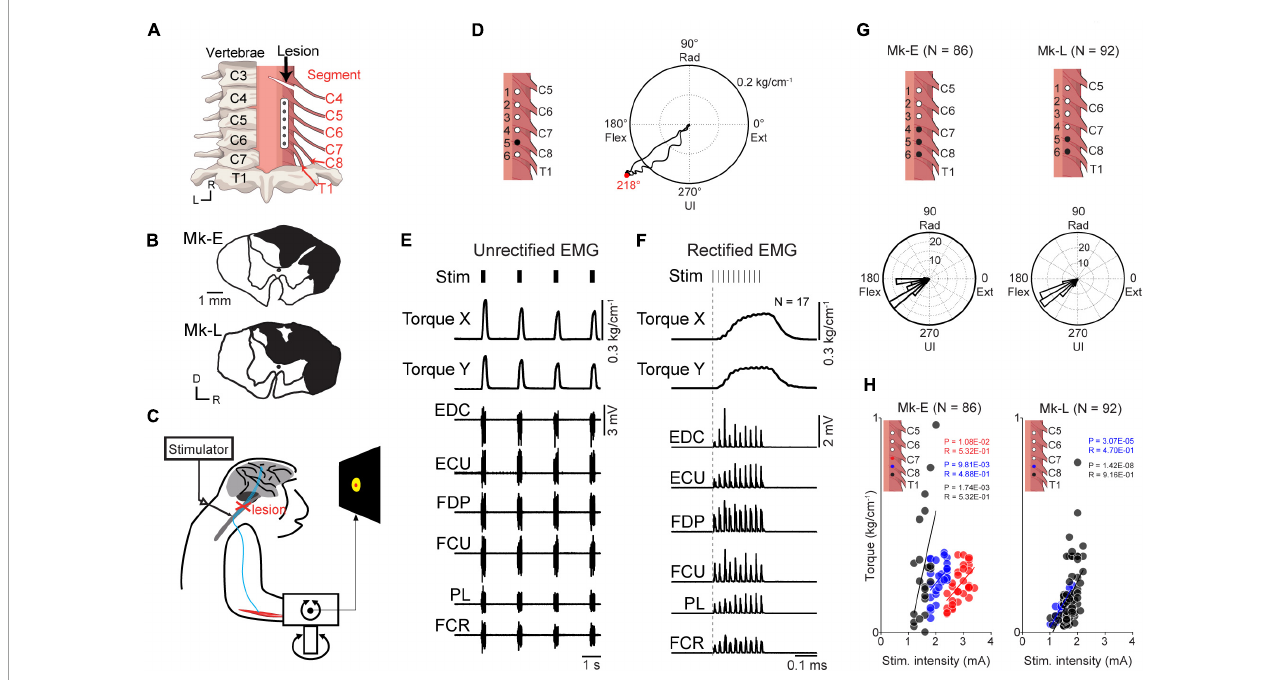
FIGURE1 Motor output evoked by subdural spinal stimulation during rest in awake monkeys with SCI. (A) A subdural 6-electrode array (platinum) was chronically implanted over the dorsal-lateral aspect of the cervical spinal cord and placed on the C6–T1 segments. A slit at the C4/C5 segment indicates the lesion site. (B) Lesion extent (black hatch) at the C4/C5 segment in individual monkeys. (C) Subdural spinal stimulation was applied at rest. (D) Typical example of average wrist torque trajectory for tonic spinal cord stimulation of C8 (black circle, electrode no. 5). Horizontal and vertical components in this trace correspond to Torque X and Torque Y in panel (F) , respectively. Red dot on the torque trajectory represents the maximum magnitude of the evoked torque. (E) Raw traces of wrist torque and EMG during subdural spinal stimulation of C8. Stimuli consisting of 10 constant-current biphasic square-wave pulses of 40 Hz with a duration of 0.2 ms and interval of 2 s were delivered through an electrode (Monkey E, post-SCI day 15). (F) Stimulus-triggered averages of wrist torque and rectified EMG. The vertical dashed gray lines represent the onset of a stimulus train. (G) Population data for the directions of the evoked torque induced by subdural spinal stimulation at rest. Top: black dots on the spinal cord indicate the stimulation sites. Bottom: histograms indicate the directions of the evoked wrist torque. (H) The relationship between the magnitude of the evoked wrist torque and stimulus intensity. Colored dots in the figures correspond to spinal stimulus sites. Significant positive correlations between the magnitude of evoked the torque and current intensity were found, shown as solid lines (Pearson correlation coefficient; P <